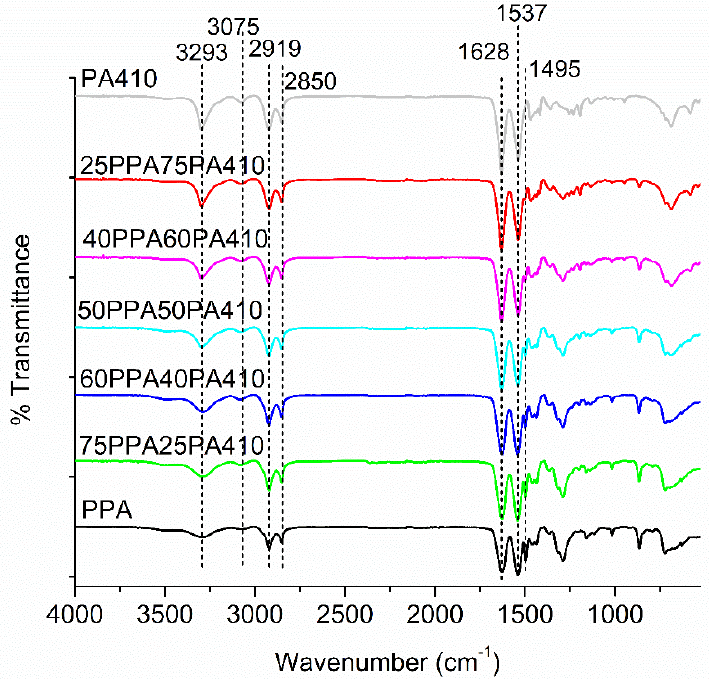
Figure 10. FTIR spectra of neat polymer and the prepared blends.